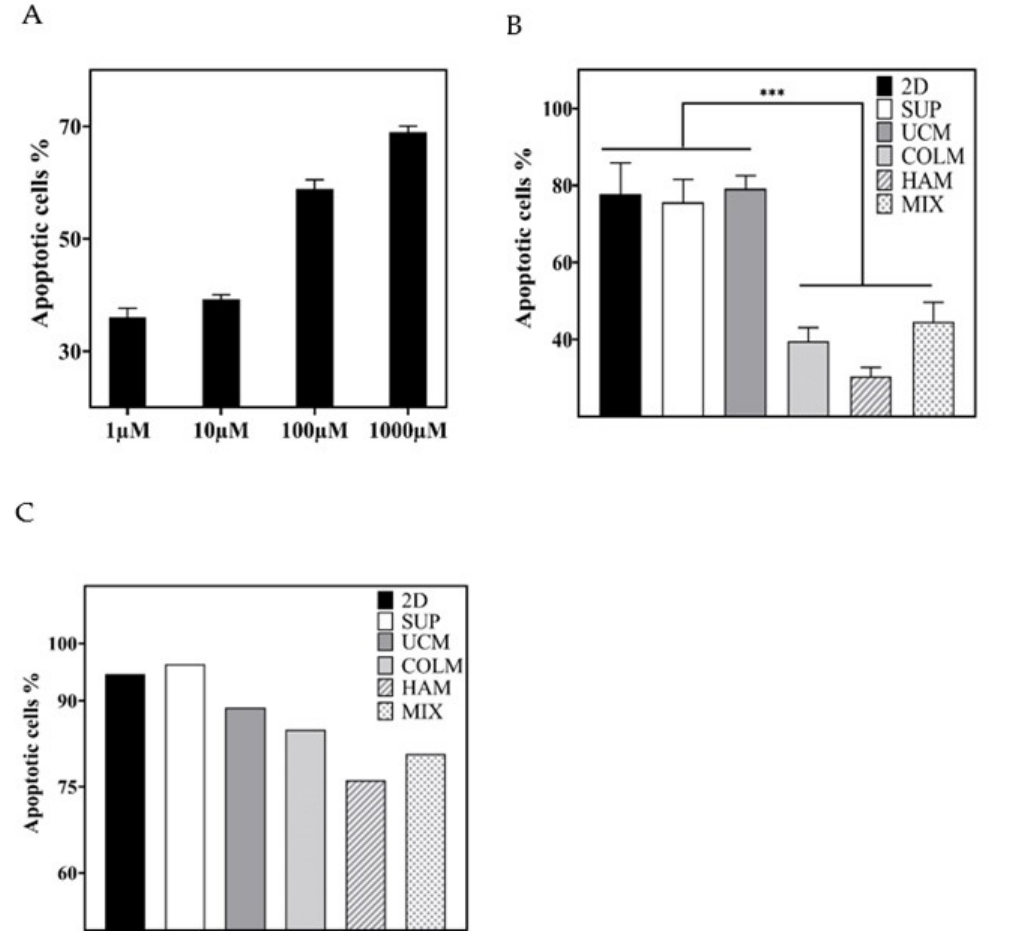
Figure 5. Percentage of apoptotic cells after exposition to DEX ( A , B ) and BRZ ( C ). 2D culture at varying DEX dose ( A ); influence of the presence of hyaluronic acid or collagen on the development of drug resistance ( B , C ). The level of statistical significance is shown as (***) p -value ≤ 0.001. 2D, conventional 2D control culture; SUP, suspension control; UCM, control with uncoated alginate microspheres; HAM, microspheres with a last layer of hyaluronic acid; COLM, microspheres with a last layer of collagen; MIX, mixture of 50% HAM and 50% COLM microspheres.